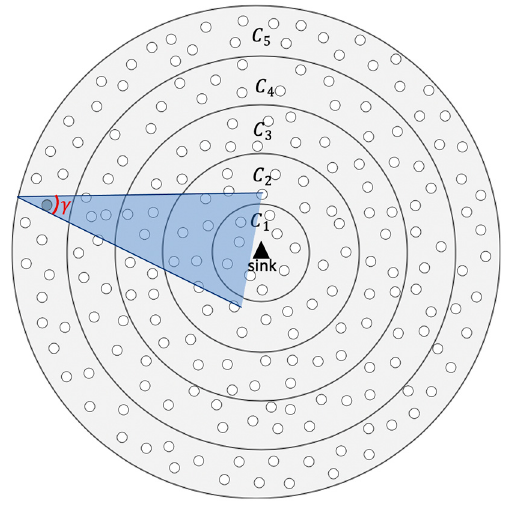
Figure 6. Gamma sector.